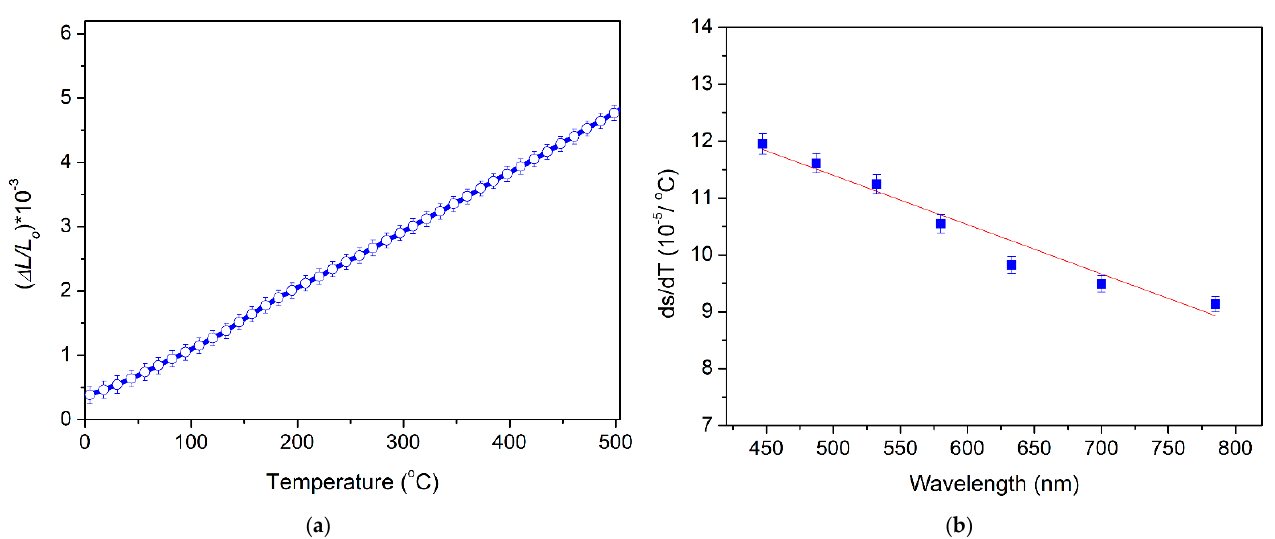
Figure 4. ( a ) The change in the length of thermal expansion for the fabricated CZ plate in the temperature range of 5 °C to 500 °C. ( b ) Temperature coefficient of the optical path length as function of wavelength for the CZ plate, with the linear fit shown by the solid red line.